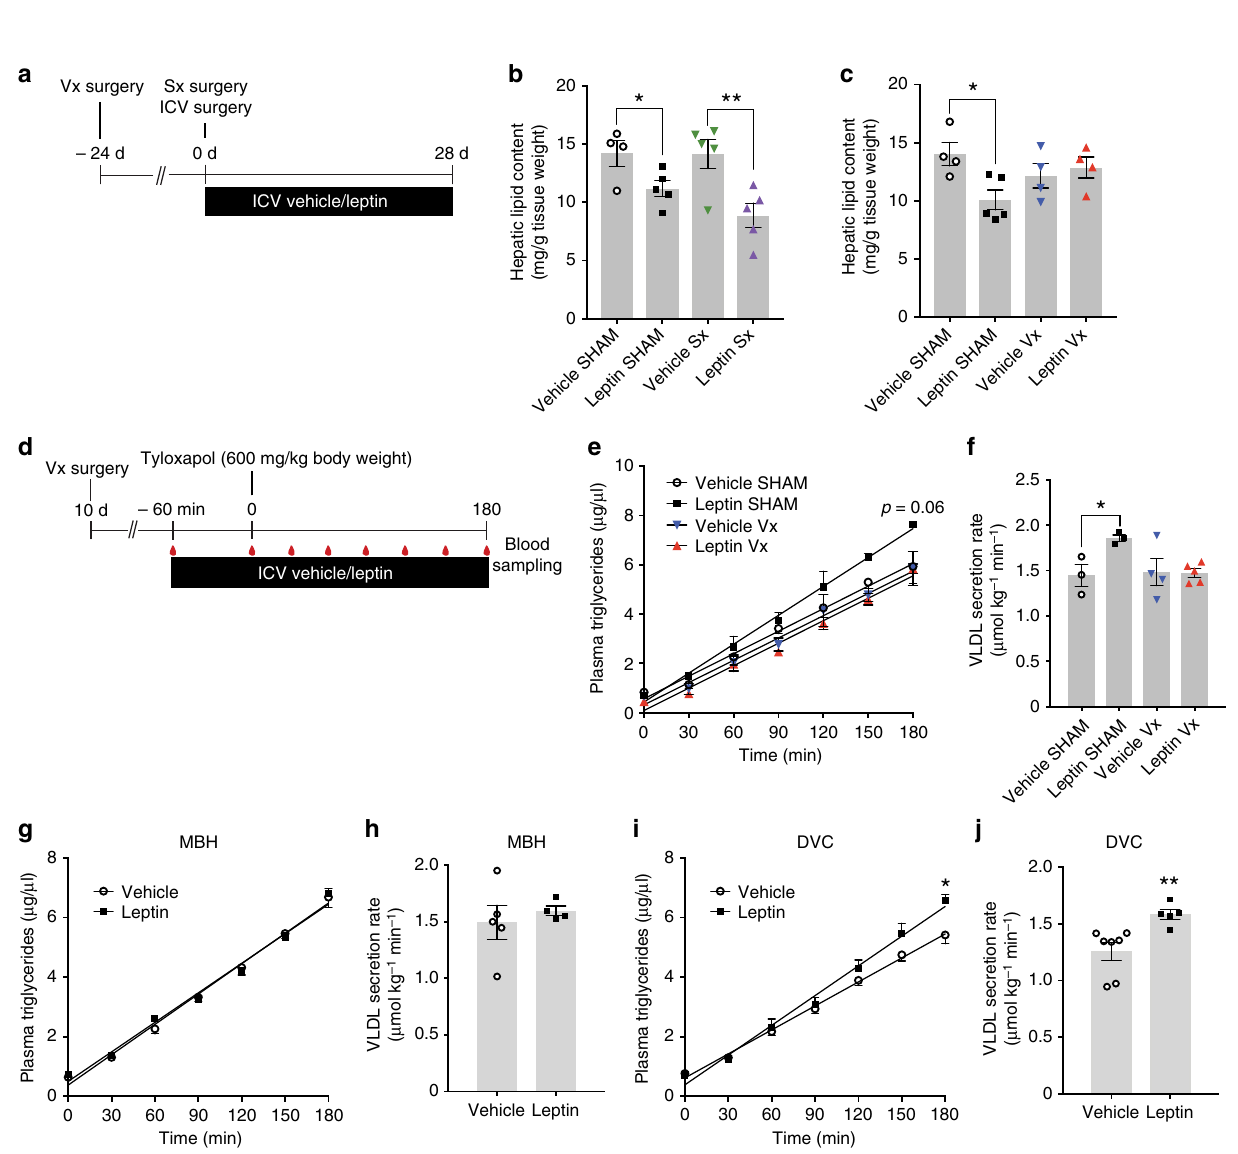
Fig. 4 ICV leptin requires intact vagal innervation to regulate hepatic lipid metabolism. a Study timeline for chronic ICV leptin/vehicle infusion studies after selective hepatic sympathectomy (Sx) or vagotomy (Vx). b , c Hepatic lipid content after selective hepatic sympathectomy ( n ≥ 4 per group) ( b ) and liver vagotomy ( n ≥ 4 per group) ( c ) after 28 days of continuous ICV leptin/vehicle infusion (Leptin: 0.3 µ g/day). d Study timeline and protocol for tyloxapol infusion studies in rats with hepatic vagotomy that received a 4 h ICV leptin/vehicle infusion. e Progressive accumulation of plasma TGs after an IV tyloxapol bolus ( n ≥ 3 per group). f VLDL secretion rates calculated from the slopes depicted in Fig. 4e. g Plasma increase in TG levels following a tyloxapol bolus after a targeted 4 h leptin/vehicle infusion directly into the mediobasal hypothalamus (MBH; n ≥ 5 per group). h VLDL secretion rates calculated from the slopes in Fig. 4g. i Plasma increase in TG levels following a tyloxapol bolus after a targeted 4 h leptin/vehicle infusion directly into the dorsal vagal complex (DVC). j VLDL secretion rates calculated from the slopes in Fig. 4i ( n ≥ 3 per group). All data are mean ± SEM; * p < 0.05; ** p < 0.01; vs vehicle group if not otherwise indicated by brackets. n.s. not signi fi cant by two-tailed Student ’ s t test; open circles: vehicle; black squares: leptin; green triangles pointing down: ICV vehicle plus liver Sx; violet triangles pointing up: ICV leptin plus liver Sx; blue triangles pointing down: ICV vehicle plus liver Vx; red triangles pointing up: ICV leptin plus liver Vx